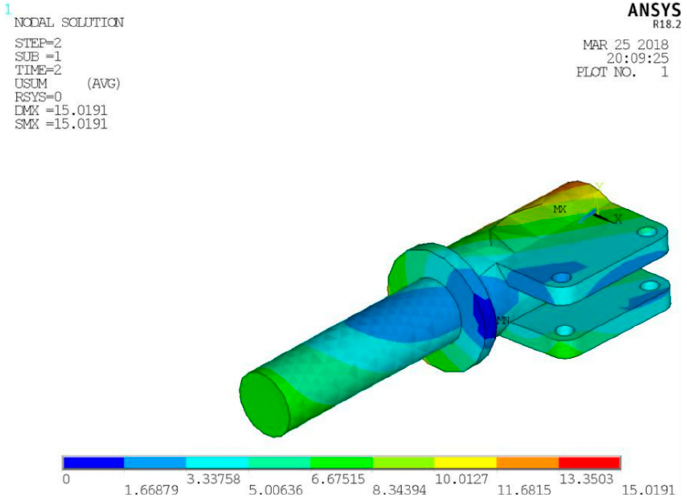
Figure 4. Stress analysis of leg joint.